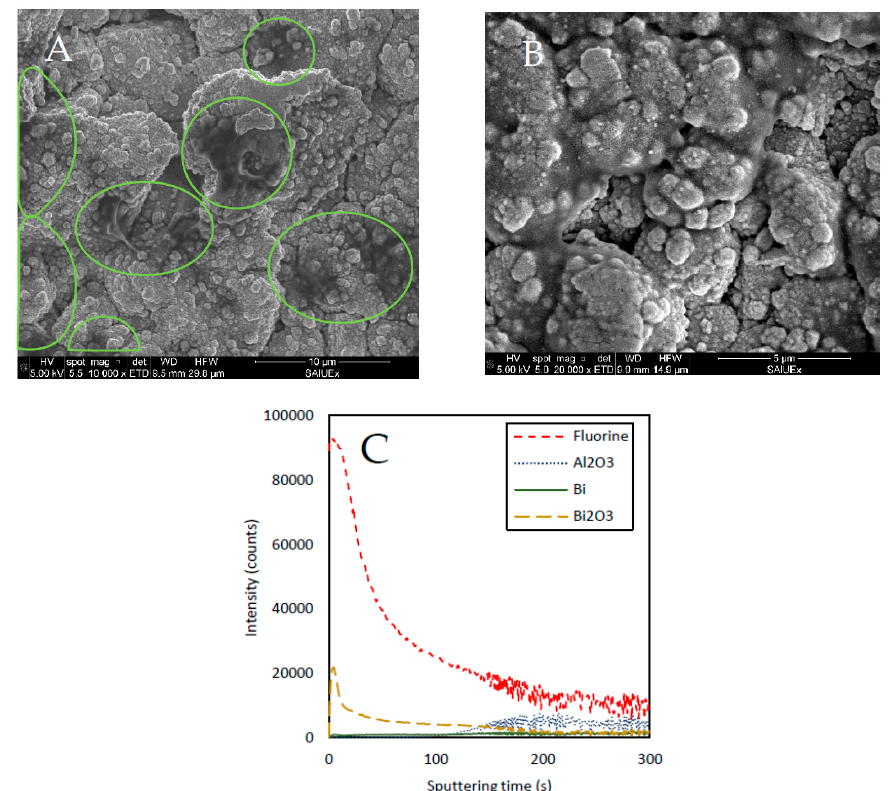
Figure 8. SEM image of commercial Bi SP SPE with Nafion additive: ( A ) New electrode modified with Nafion, ( B ) Modified electrode after 25 SWASV measurements, ( C ) TOF-SIMS results.